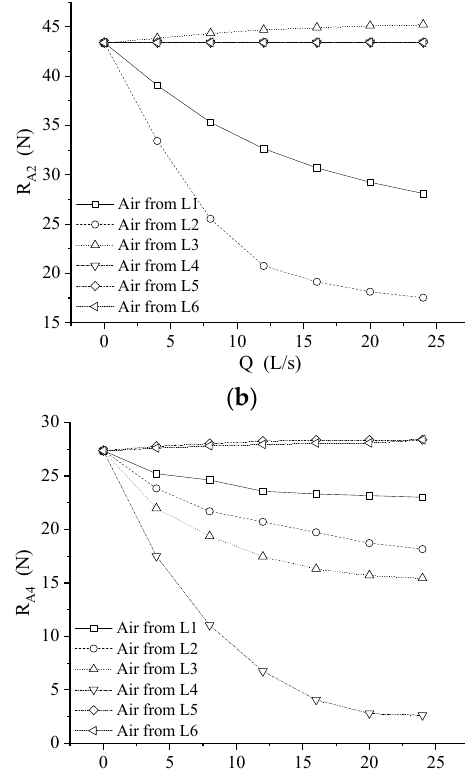
( c ) Figure 17. Volume fraction of air of the strut: ( a ) Without air injection; ( b ) Injected from L1, Air fl ow rate = 24 L/s; ( c ) Injected from L3, Air fl ow rate = 24 L/s. The volume fractions of air of the strut are shown in Figure 17, in which the di ff erent